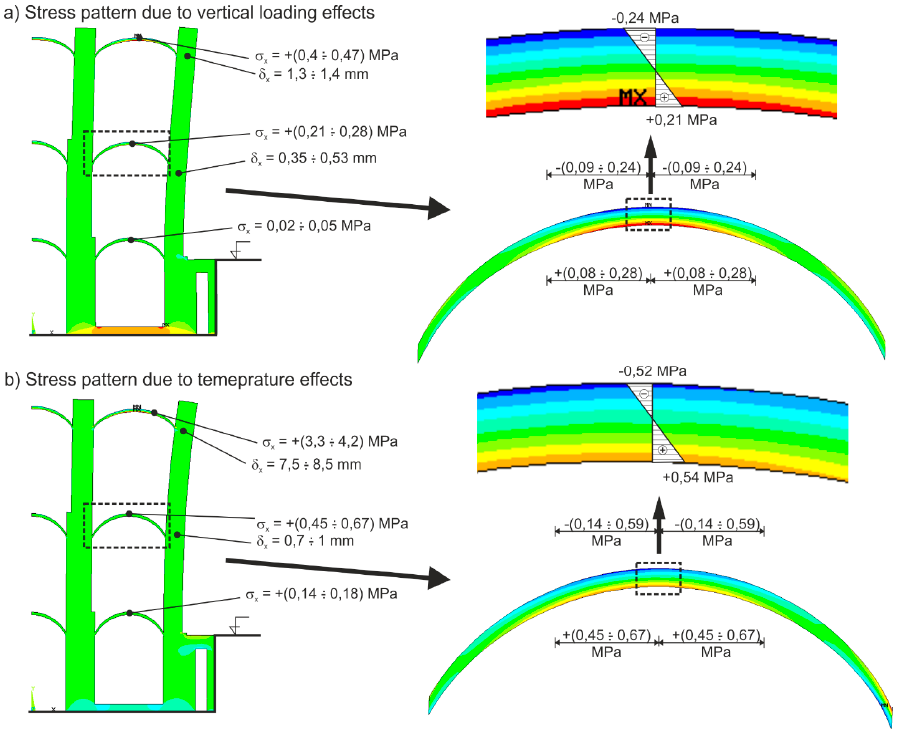
Figure 6. ( a ) Stress-state analysis of the vault structure due to vertical loading effects; ( b ) Stress-state analysis of the vault structure due to temperature effects. analysis of the vault structure due to temperature